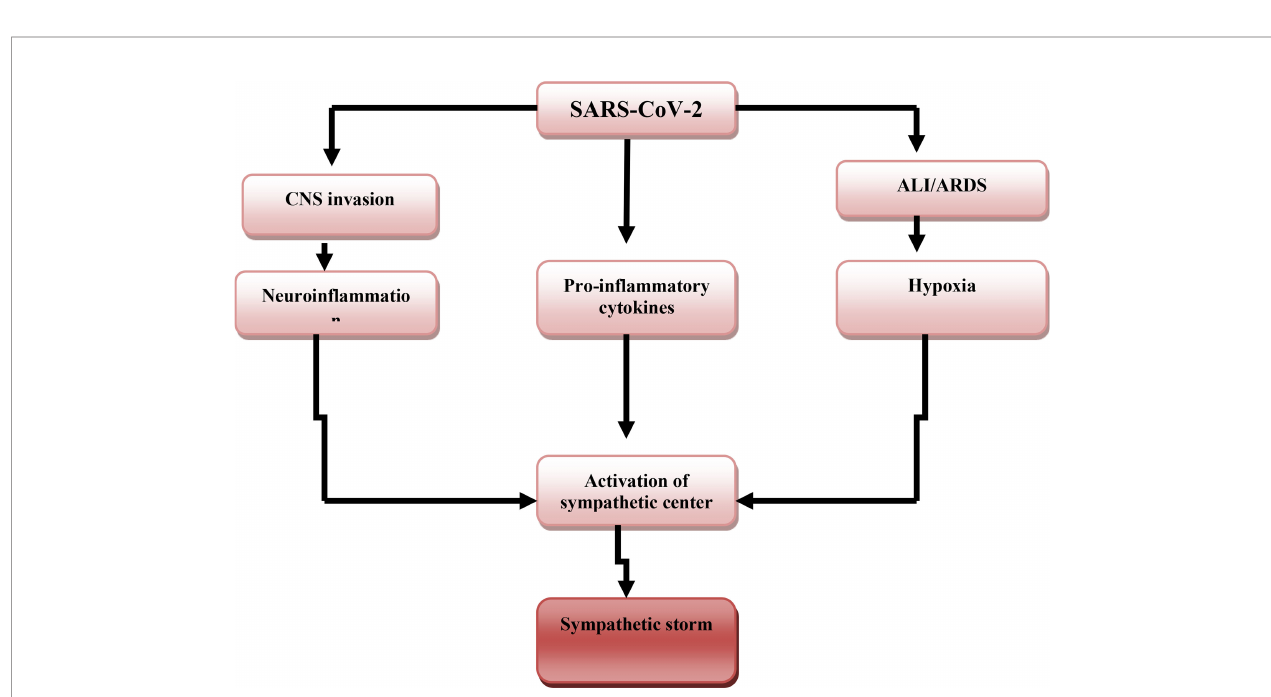
FIGURE 2 | SARS-CoV-2-induced sympathetic storm. SARS-CoV-2 acute lung injury (ALI) and acute respiratory distress syndrome (ARDS)-induced hypoxia, SARS- CoV-2-induced neuroin fl ammation, and release of pro-in fl ammatory cytokines activate the central sympathetic center with the development of the sympathetic storm.